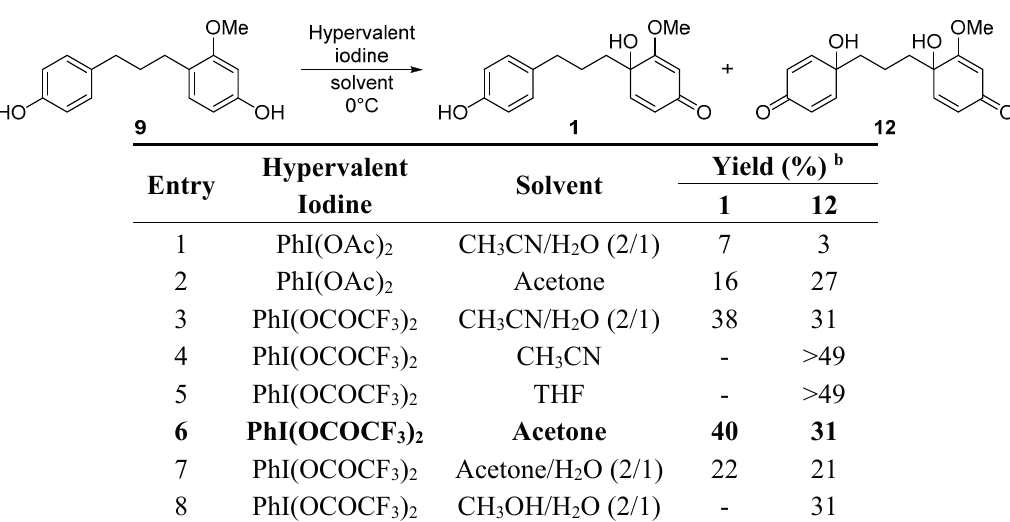
Table 2. Optimization of oxidative dearomatization a .